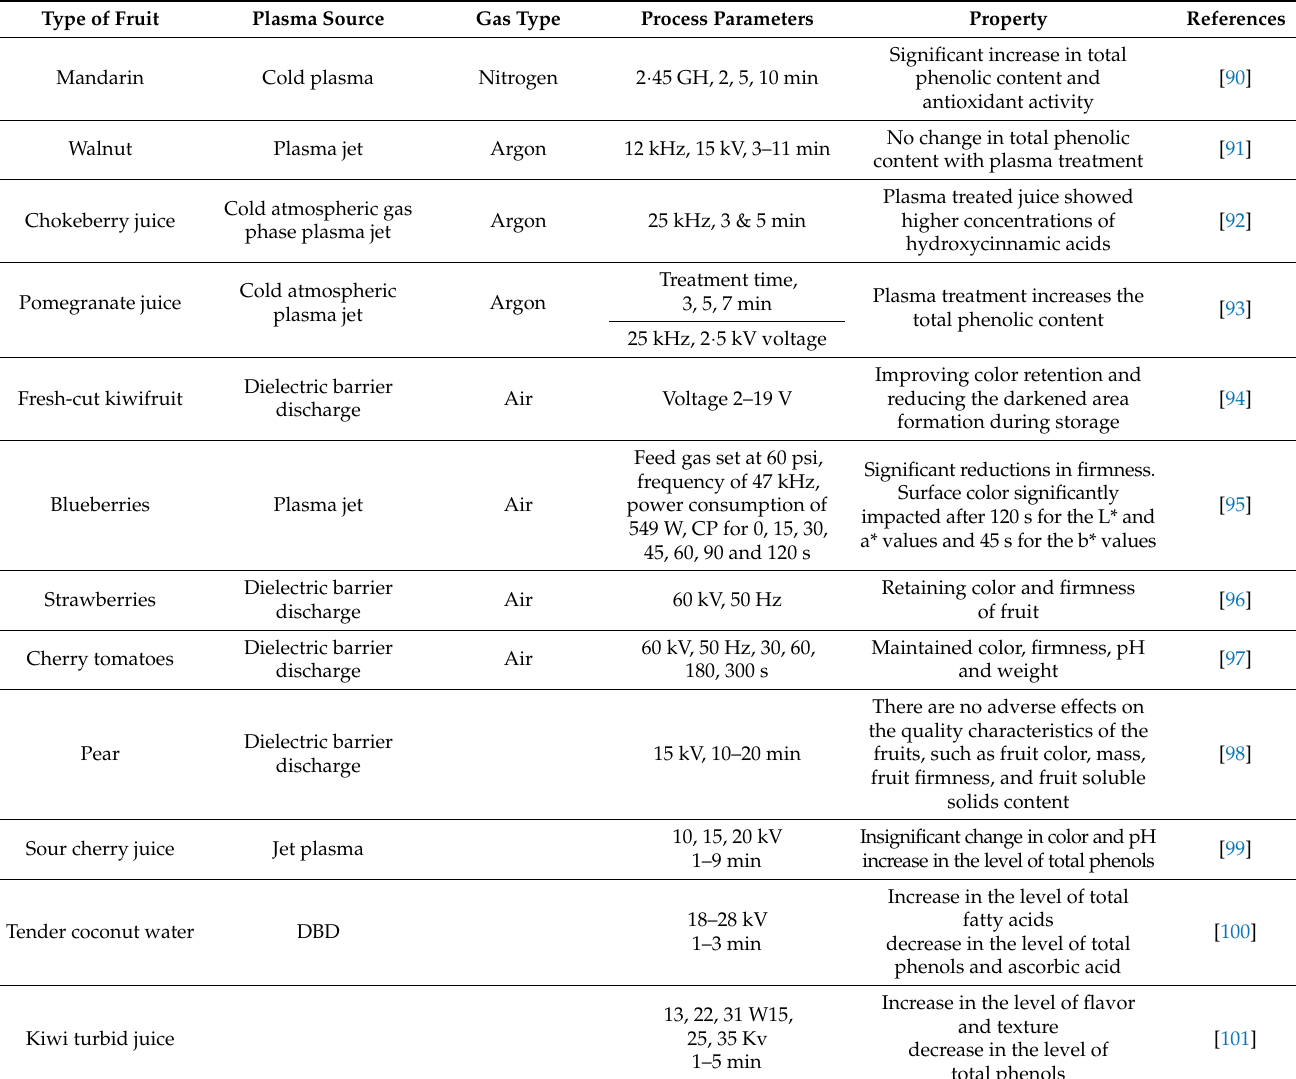
Table 4. The effect of cold plasma on fruit quality characteristics